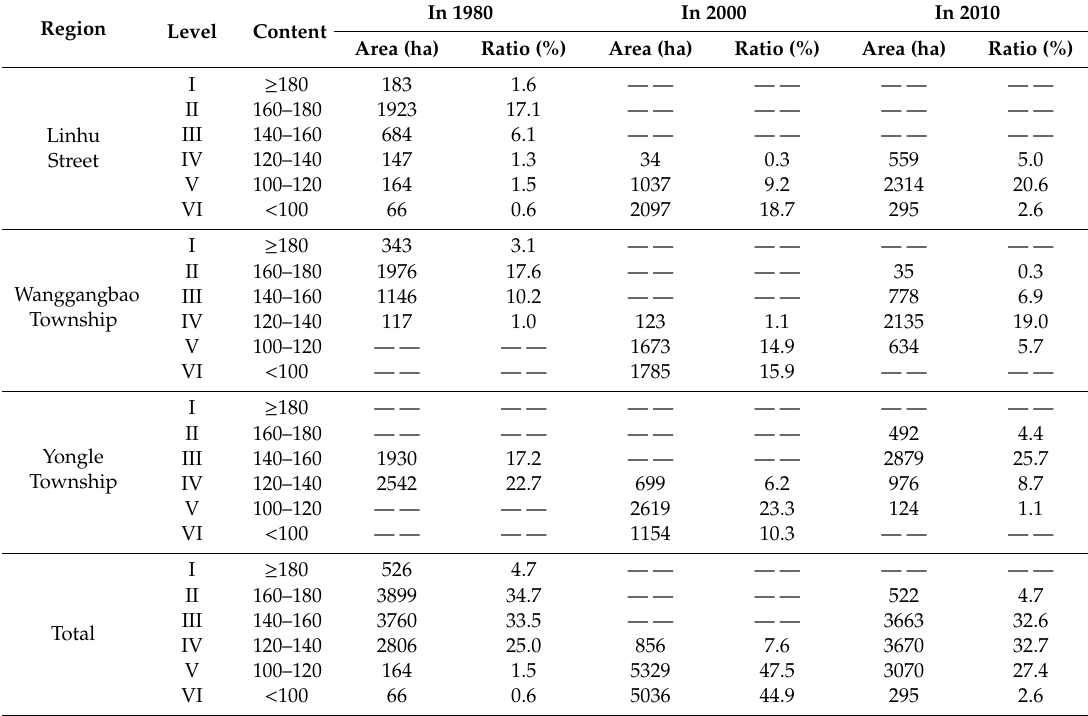
Table 1. Statistics on the area of AVK in various levels from 1980 to 2010.